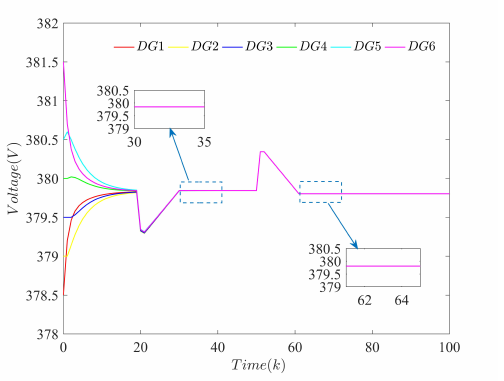
Figure 5. Performance of the proposed strategy under load disturbance and no